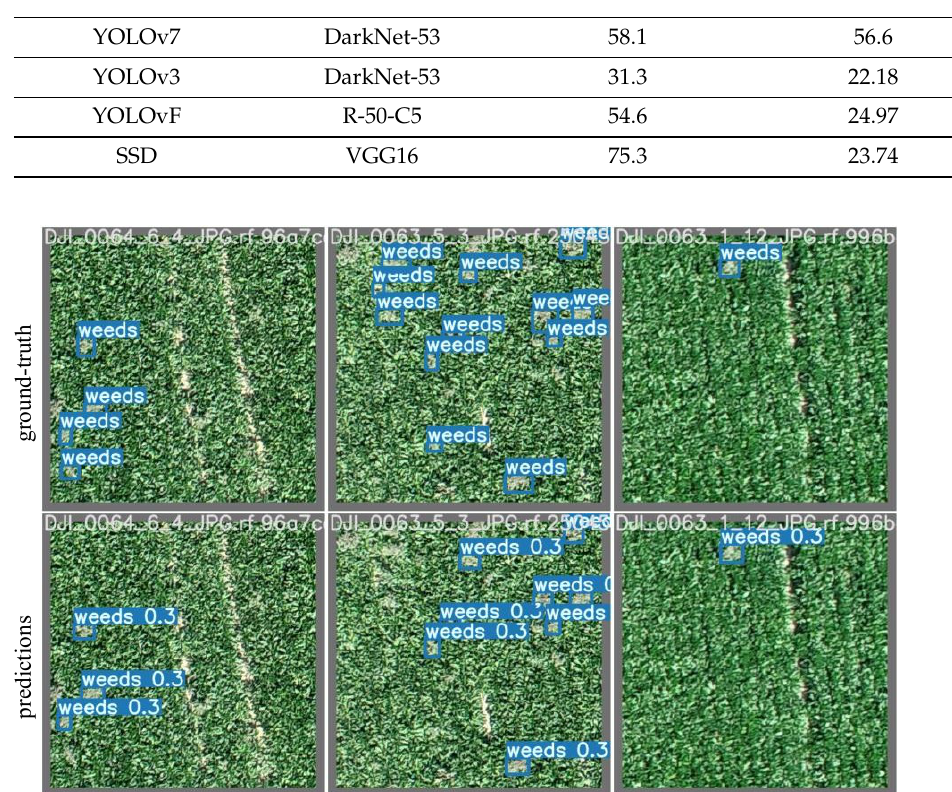
Figure 5. Some examples of YOLOv7 detections on CP test images. The top row contains some test images of the CP dataset with ground truth bounding boxes labeled as “weeds”. In the bottom row, the same images are shown but with the bounding boxes predicted by the YOLOv7